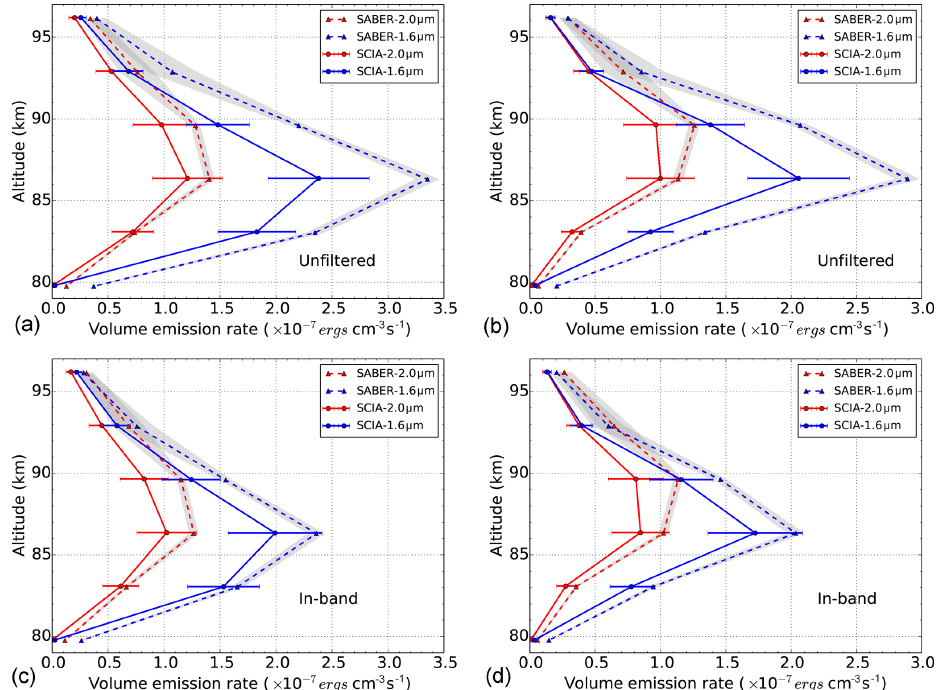
Figure 4. SABER 1.6 and 2.0µm unfiltered (a, b) and in-band (c, d) volume emission rates and corresponding simulations from SCIA- MACHY data for September 2005 at latitude bins 0–20 ◦ N (a, c) and 20–40 ◦ N (b, d) The horizontal lines represent error bars considering the total uncertainties discussed in Sect. 4.1. The grey shaded area represents the observed accuracy of SABER 1.6 and 2.0µm